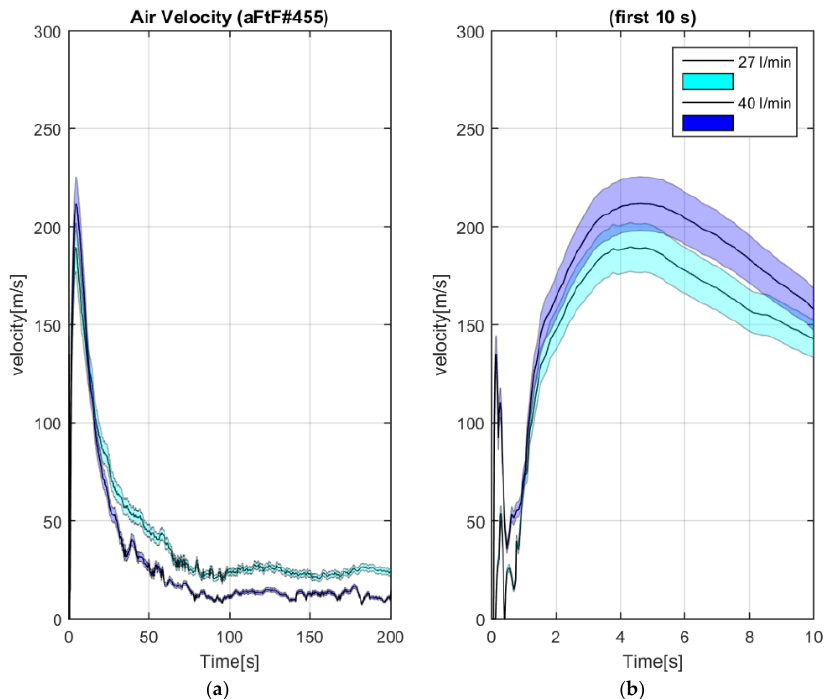
Figure 16 . ( a ) Description of the velocities variation during the whole experiments. ( b ) A detail of the velocities variation in the first 10 s.